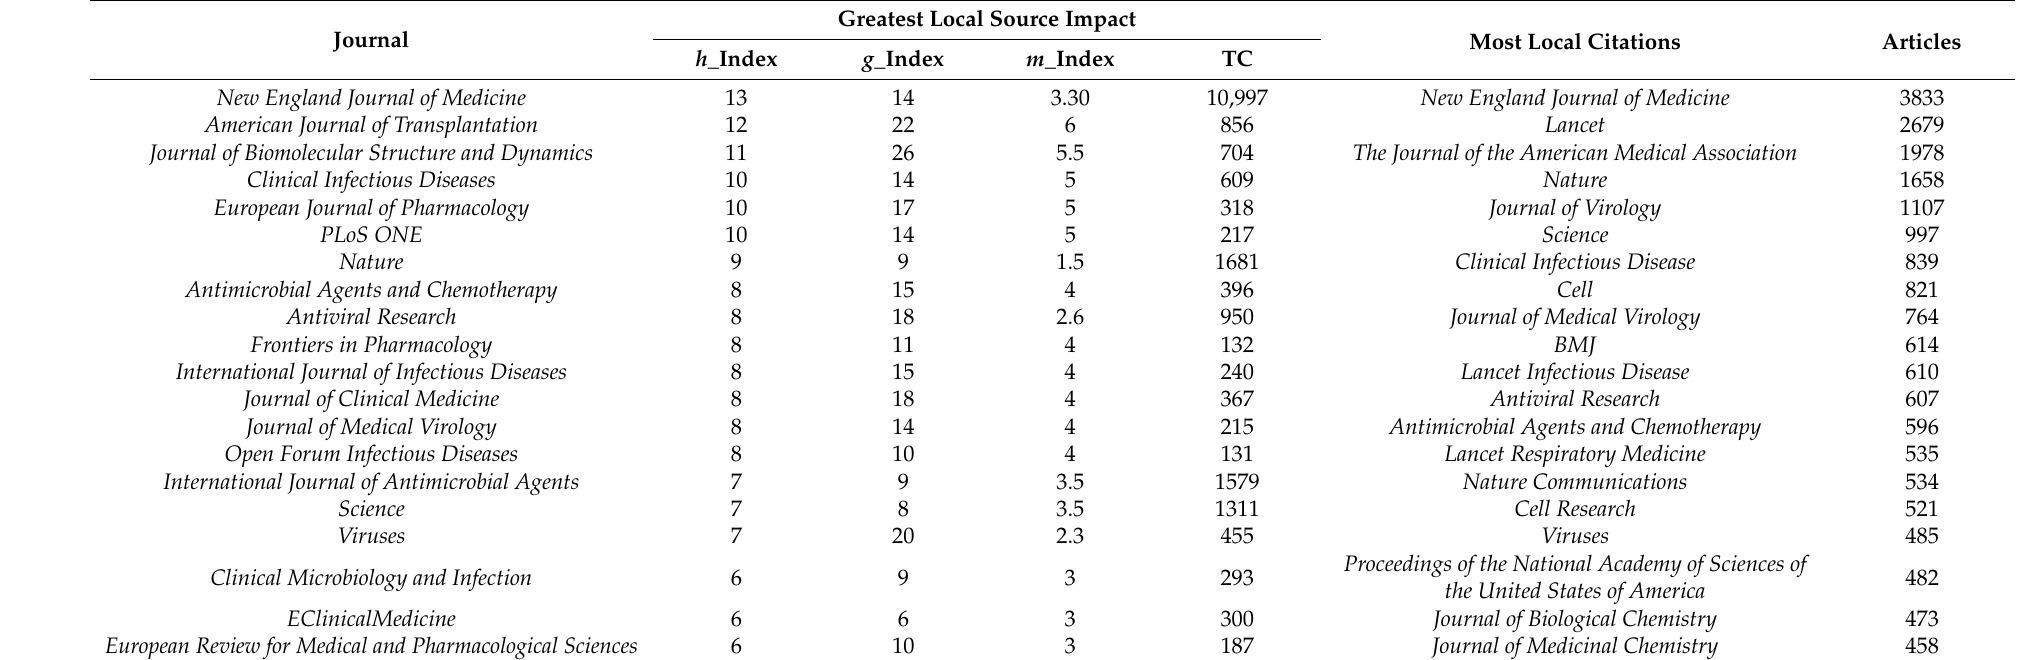
Table 2. Top 20 most local cited sources and source local